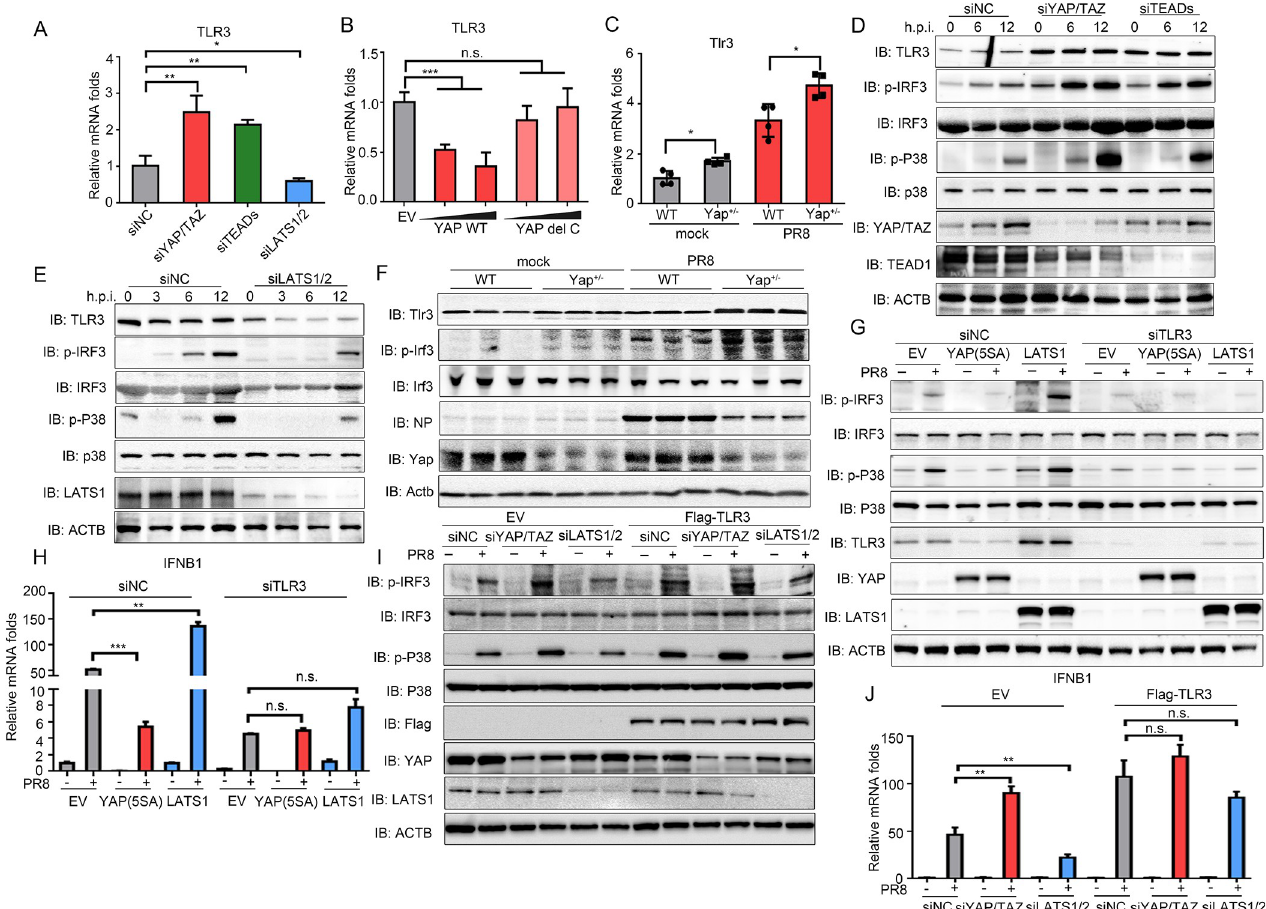
Fig 5. YAP/TAZ inhibit TLR3-mediated innate immune responses. (A, B) A549 cells were transfected with siRNAs targeting YAP/TAZ, TEADs and LATS1/ 2 (A), or transfected with plasmids of YAP and YAP del C (B). Transcriptional level of TLR3 was measured. (C) WT and Yap +/- mice (n = 4 per group) were infected with PR8 virus or corresponding mock control. Tlr3 expression in lung tissue was assessed by RT-qPCR. (D, E) A549 cells were infected with PR8 virus for indicated time after knockdown of YAP/TAZ, TEADs (D) or LATS1/2 (E). The cells were then harvested and subjected to immunoblotting. (F) WT or Yap +/- mice were infected with virus for 24 hours, and then the lungs were analyzed by immunoblotting with indicated antibodies. (G, H) EV-, YAP(5SA)-, and LATS1-stably expressing cells were transfected with siNC or siTLR3, and then infected with PR8 virus for 12 hours. Indicated protein expression levels were determined by immunoblotting (G). IFNB1 mRNA expression level was measured by RT-qPCR (H). (I, J) A549 cells stably expressing EV or TLR3 were transfected with siNC, siYAP/TAZ and siLATS1/2, and then infected with PR8 virus. Indicated protein expression levels were determined by immunoblotting (I). IFNB1 mRNA expression level was measured by RT-qPCR (J). Data in (A-B), (D-E) and (G-J) were repeated at least three times. Data in (A-C), (H) and (J) are presented as means ± SD. � p < 0.05, �� p < 0.01, ��� p < 0.001. n.s., not significant ( p >